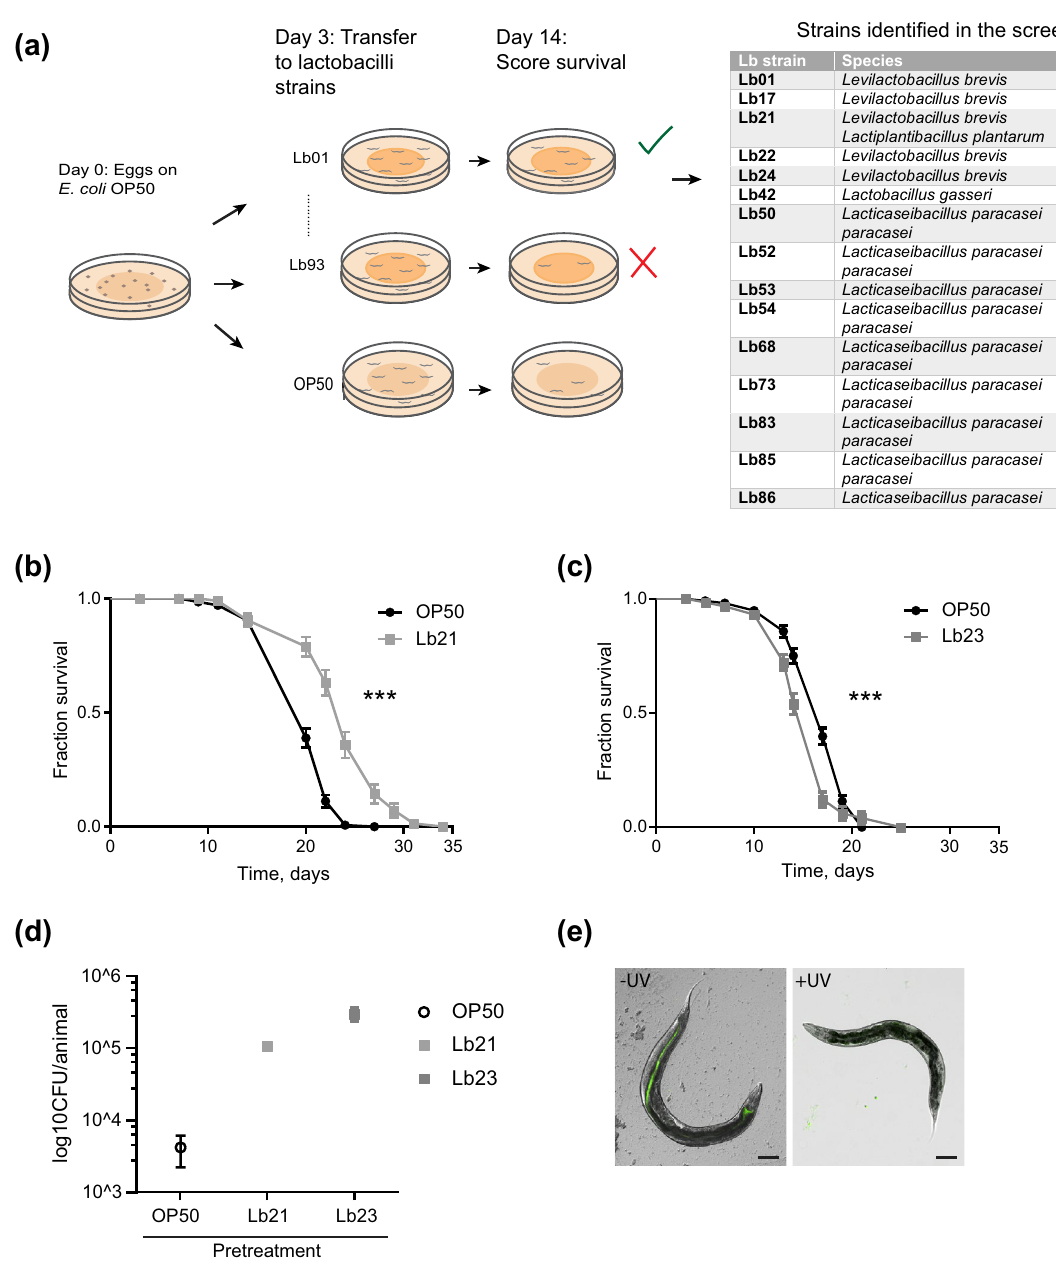
Figure 1. Identifying probiotic lactobacilli strains using C. elegans . ( a ) Outline of screening setup to detect bacteria that extend nematode lifespan compared to control bacteria, E. coli OP50 and strains isolated in the screen. ( b ) Lifespan of rrf-3 ( pk1426 ) mutants feeding on Lactobacillus spp. Lb21 compared to control bacteria, OP50. ( c ) Lifespan of rrf-3(pk1426) mutants feeding on Lactobacillus strain Lb23 compared to control bacteria, OP50. ( d ) CFU levels on day 5 of animals fed OP50 expressing GFP (OP50-GFP) until adulthood (day 3) and then shifted to Lb21, Lb23 or OP50 for 48 h (n = 10). ( e ) Localization and level of OP50-GFP after 5 days ± UV treatment of plates seeded with OP50-GFP. Scale bar = 100 μm. Graphs show a representative experiment from several independent experiments. See Table S1 for mean ± SD and log-rank test